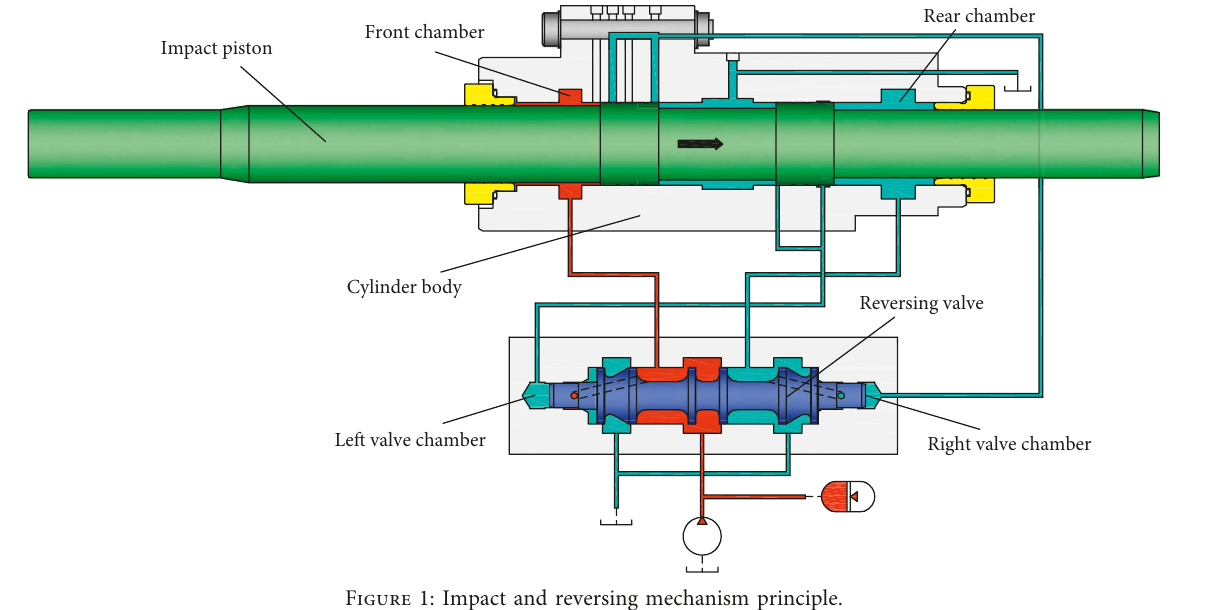
Figure 1: Impact and reversing mechanism principle.